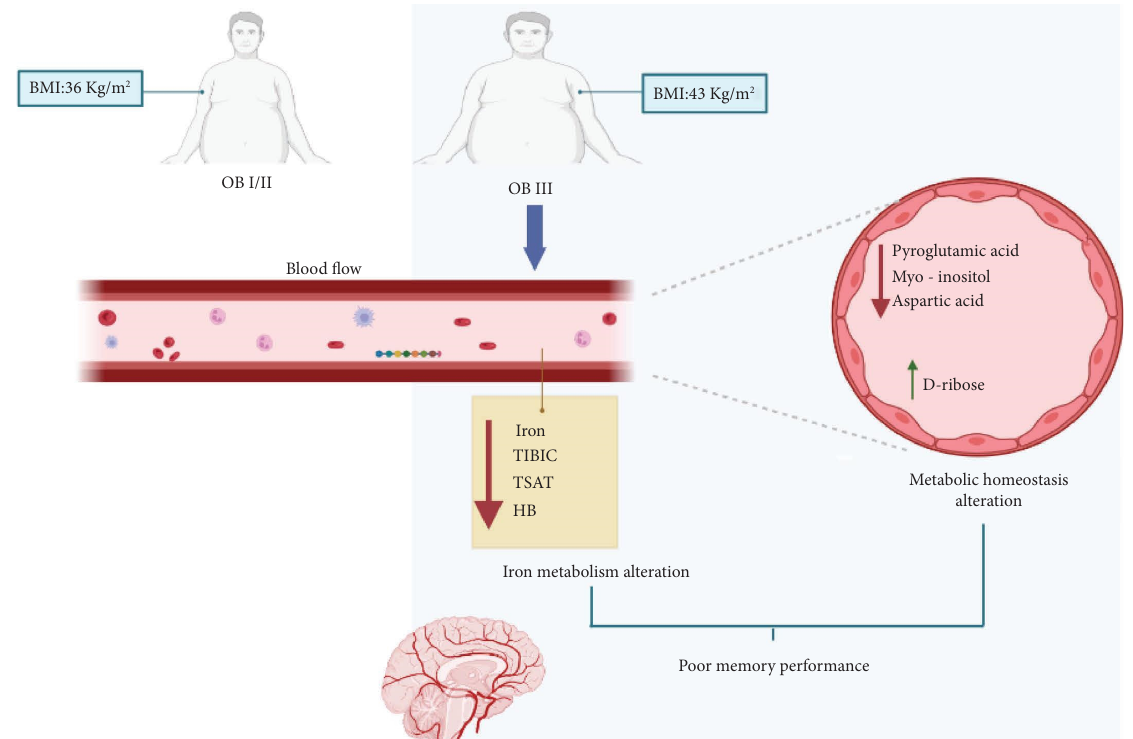
Figure 6: Subjects with class III obesity showed lower iron status, which may have altered the levels of some circulating metabolites related to oxidative stress and the cognitive